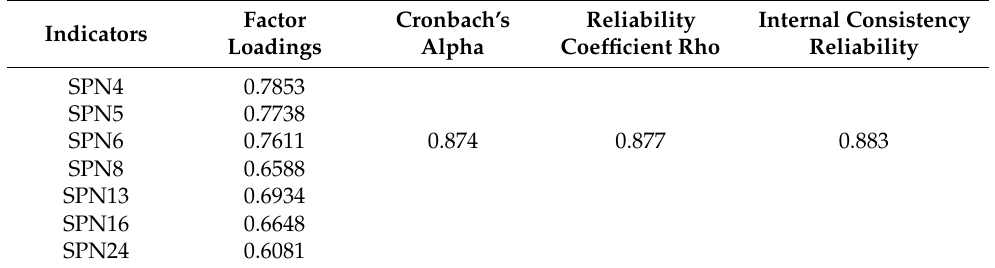
Table 12. Reliability and construct validity of the stakeholders participation measurement